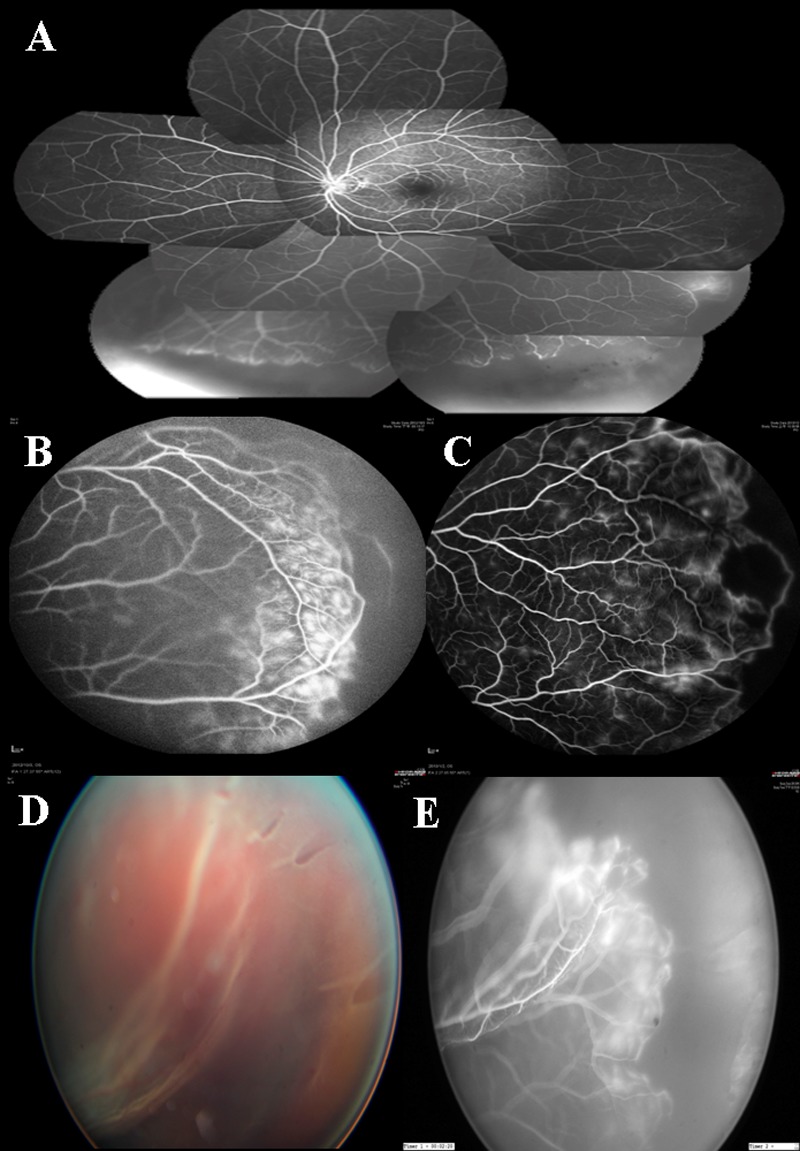
Color fundus and FA photos of group 3 eyes (A) Fluorescein angiography of an eye with group 3 retinal vasculature. Note there is anastomosis at the temporal and lower peripheral vasculature, with a wide non-perfusion at the temporal and lower aspect being noted. Vascular leakage is noted at some parts of the inferior and peripheral detached retina. (B) Another eye with type 3 vascular pattern showing circumferential route of peripheral vasculature, with peripheral non-perfusion, telangiectatic vessels and marked leakage. (C) Another eye with type 3 vascular pattern showing circumferential route and anastomosing vasculature forming a vascular loop with non-perfusion within the loop. Vascular leakage and telangiectasia were also noted. (D) Fundus photo of an eye with type 3 vascular pattern showing multiple tears without lattice degeneration. (E) Fluorescein angiography of the same patient showing that all the tears are in the peripheral non-perfused retina.